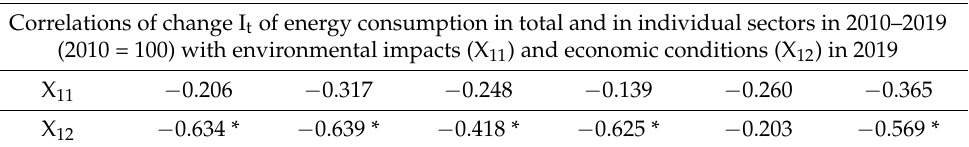
Table 9. Correlations of variables characterising energy consumption and greenhouse gas emissions from energy in 2019 (variables X 01 –X 11 ), and the index I t representing change of values of these variables in 2010–2019 (2010 = 100) in EU (27) countries. Variable I tX01 I tX02 I tX03 I tX04 I tX05 I tX06 Correlations of energy consumption in 2019 with change I t of energy consumption in total and in individual sectors in 2010–2019 (2010 = 100) X 01 − 0.473 * − 0.546 * − 0.394 * − 0.483 * − 0.286 − 0.456 * X 02 − 0.443 * − 0.493 * − 0.354 − 0.451 * − 0.217 − 0.453 * X 03 − 0.248 − 0.383 * − 0.169 − 0.326 − 0.348 − 0.299 X 04 − 0.332 − 0.352 − 0.346 − 0.333 − 0.003 − 0.379 X 05 − 0.563 * − 0.533 * − 0.435 * − 0.548 * − 0.126 − 0.416 * X 06 − 0.323 − 0.402 * − 0.133 − 0.254 − 0.450 * − 0.461 * Correlations of change I t of energy consumption in total and in individual sectors in 2010–2019 (2010 = 100) with environmental impacts (X 11 ) and economic conditions (X 12 ) in 2019 X 11 − 0.206 − 0.317 − 0.248 − 0.139 − 0.260 − 0.365 X 12 − 0.634 * − 0.639 * − 0.418 * − 0.625 * − 0.203 − 0.569